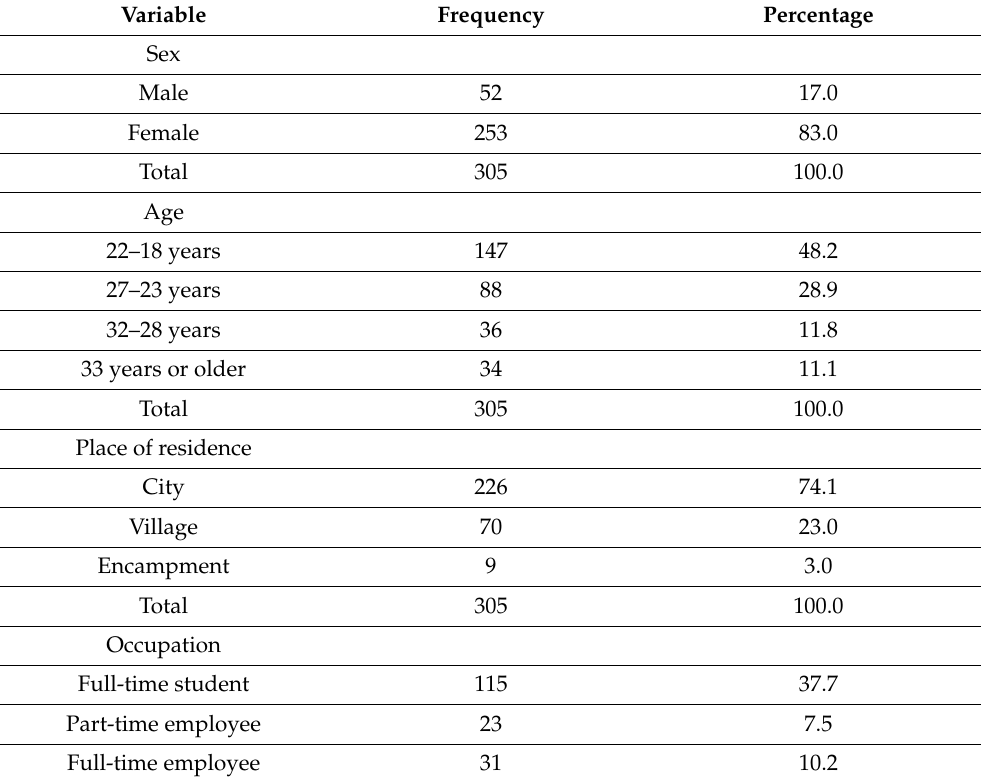
Table 1. Distribution of the sample individuals according to demographic